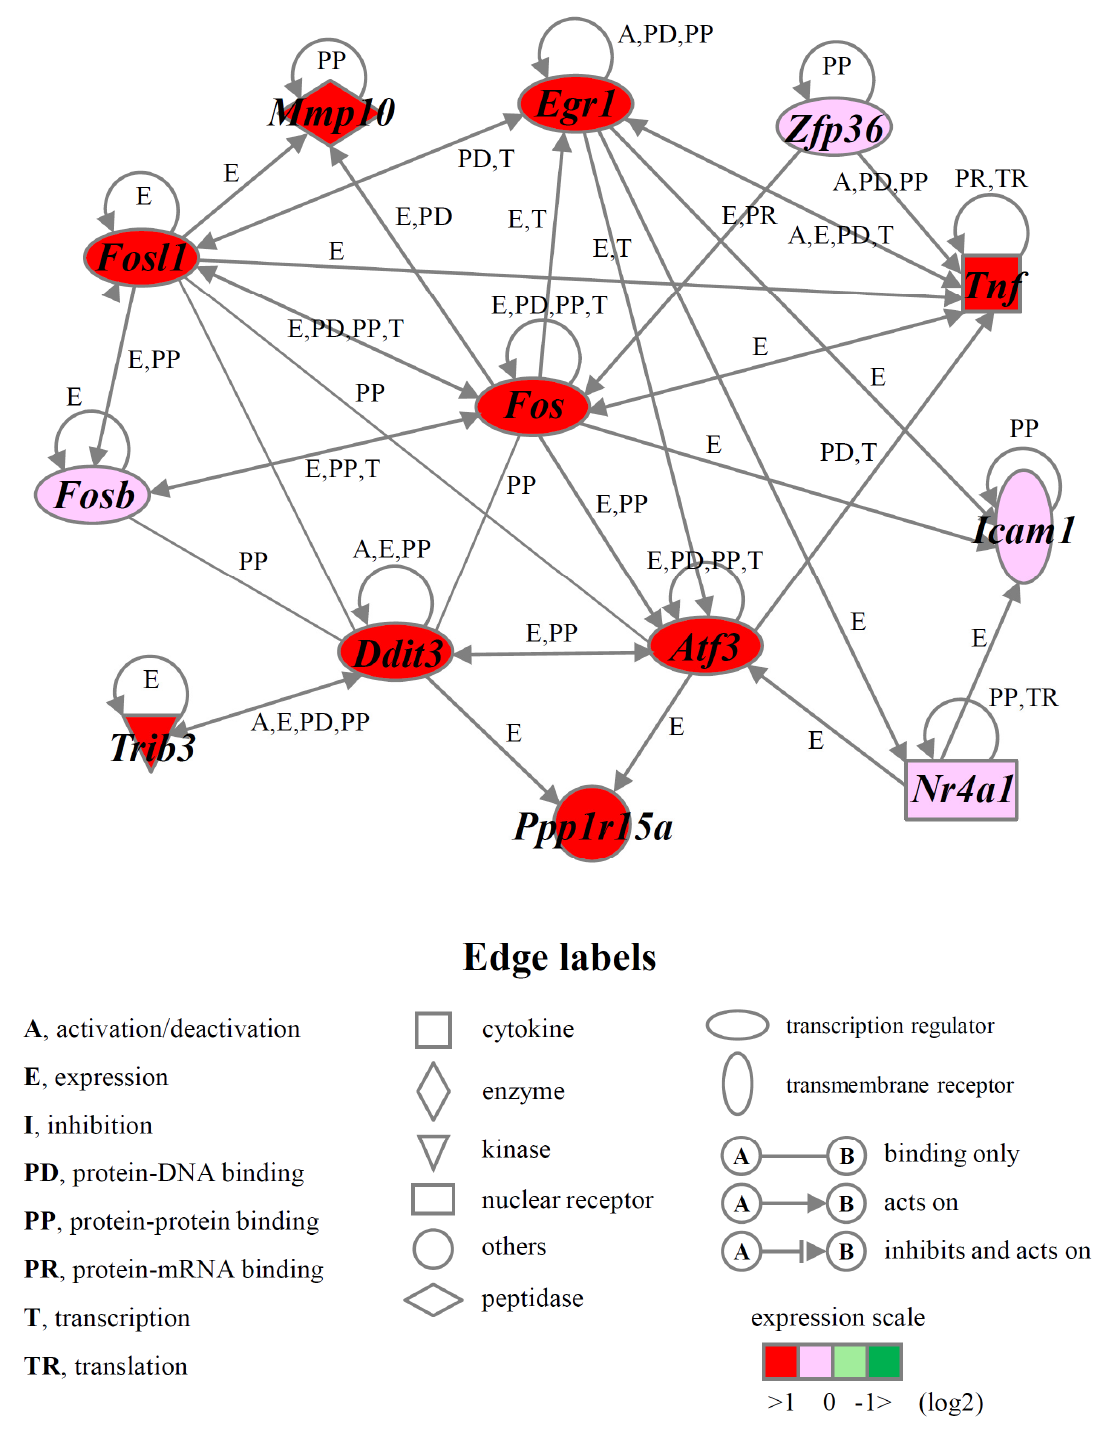
Figure 6. A gene network Up-I. Genes that were up-regulated in the cluster Up-I were analyzed by the Ingenuity ® Pathway analysis software. The network is displayed graphically as nodes (genes) and edges (the biological relationships between the nodes). Nodes and edges are displayed as various shapes and labels that present the functional class of genes and the nature of the relationship between the nodes,